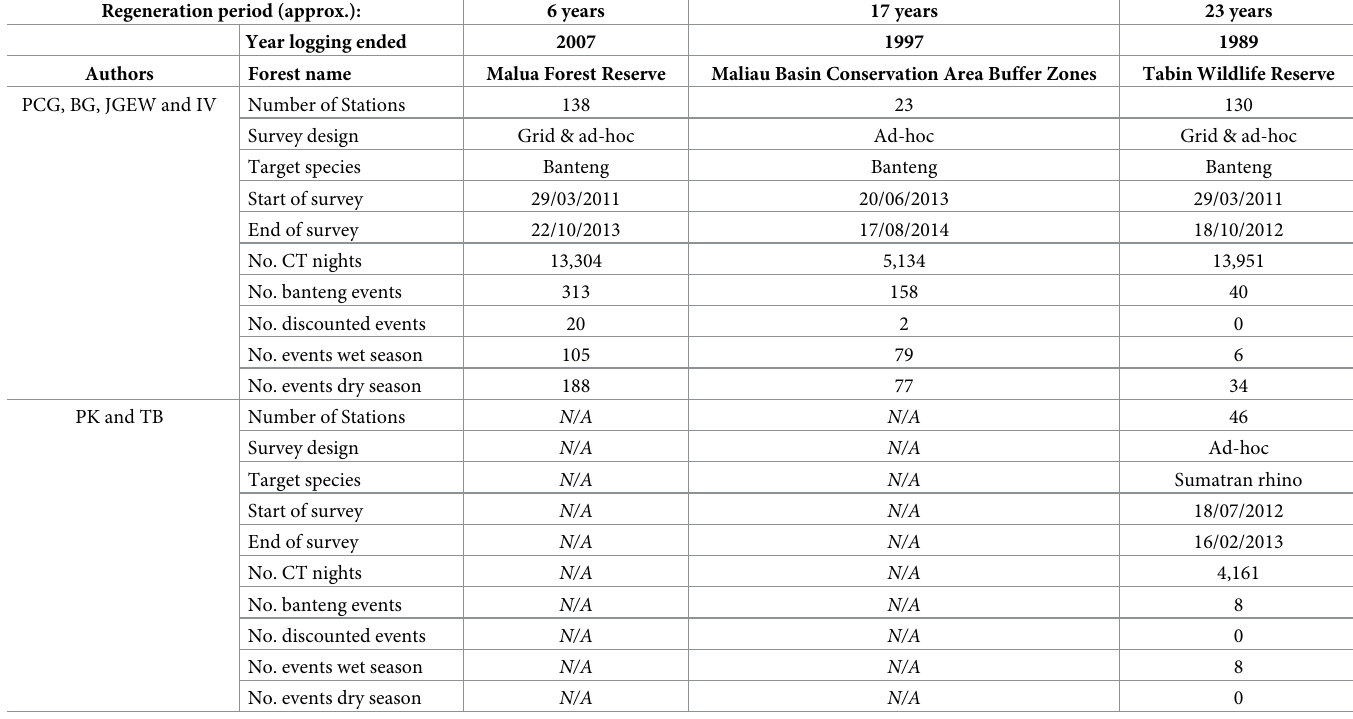
Table 1. Summary of camera trap surveys in three regenerating logged forests in Sabah, Malaysian Borneo. Regeneration period